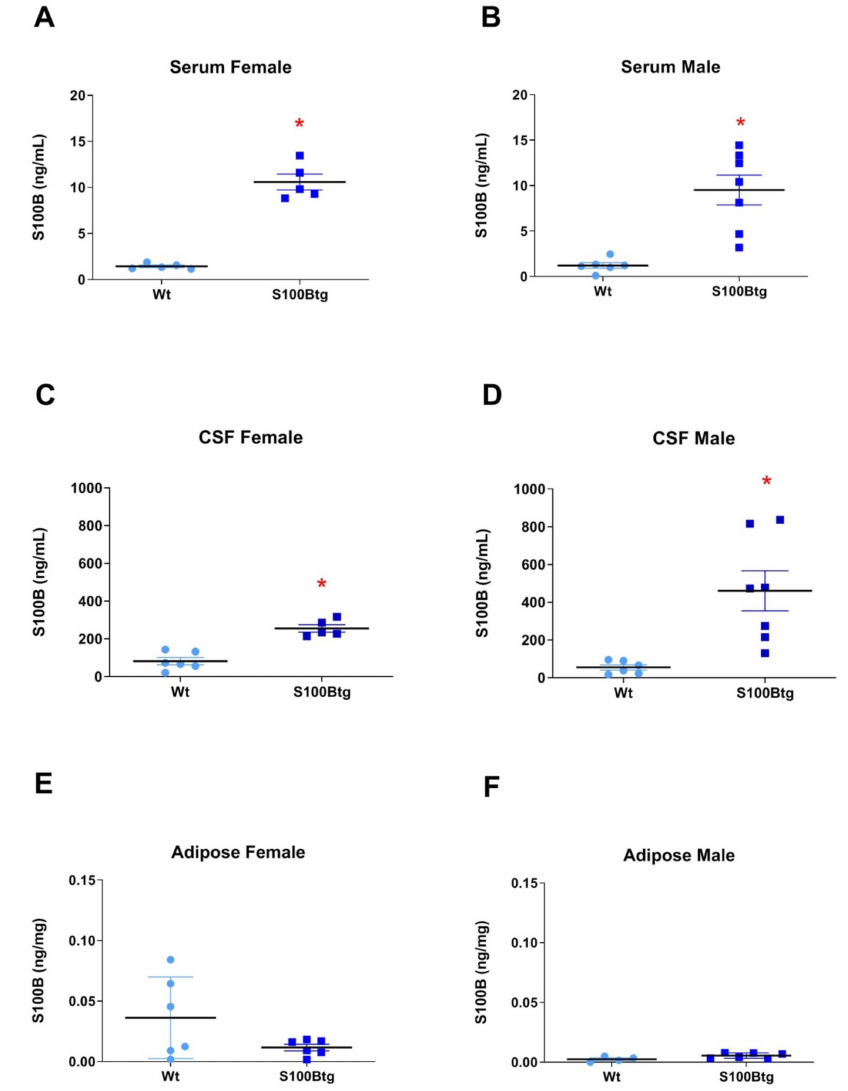
Figure 1. S100B level in blood serum, cerebrospinal fluid, and adipose tissue in one-year-old S100Btg and wt mice: in ( A , B ) serum concentration of S100B in females and males; in ( C , D ), cerebrospinal fluid (CSF) concentration of S100B in females and males; in ( E , F ), adipose tissue content of S100B in females and males; measurements performed by ELISA. Data are expressed as means ± SE (7 mice/group). * indicates a statistically significant difference (Student’s t -test, assuming p < 0.05). The S100B brain content was measured in three different regions: hippocampus, frontal cortex, and hypothalamus. In all three brain regions, the S100B content was increased in S100Btg mice, i.e., in female (hippocampus: Figure 2A, p = 0.0134; frontal cortex: Figure 2C, p < 0.0001; hypothalamus: Figure 2E, p < 0.0001) and in male (hippocampus: Figure 2B, p = 0.0157; frontal cortex: Figure 2D, p < 0.0001; hypothalamus: Figure 2F, p < 0.0001) S100Btg mice, as compared with wt